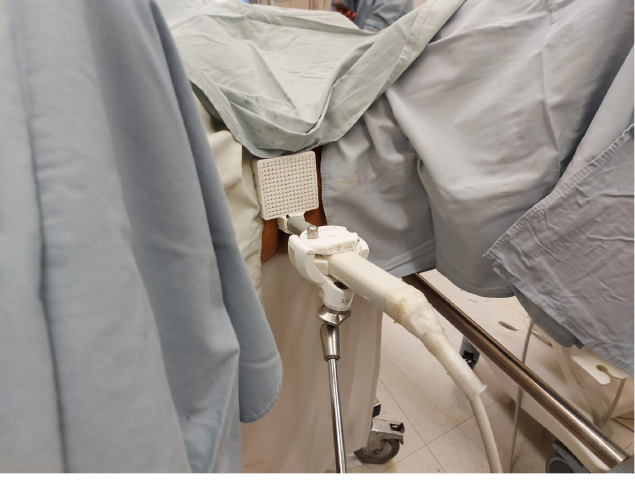
Figure 1. Patient prepped and draped in the lithotomy position. US probe and grid mounted on a stable stepper. US,